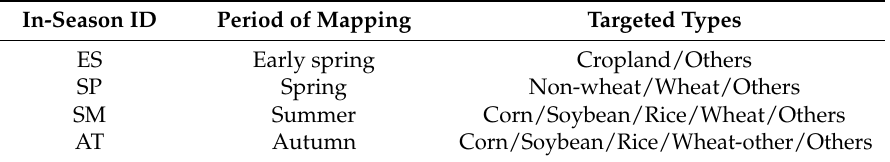
Table 2. Four different seasons and its mapping crop